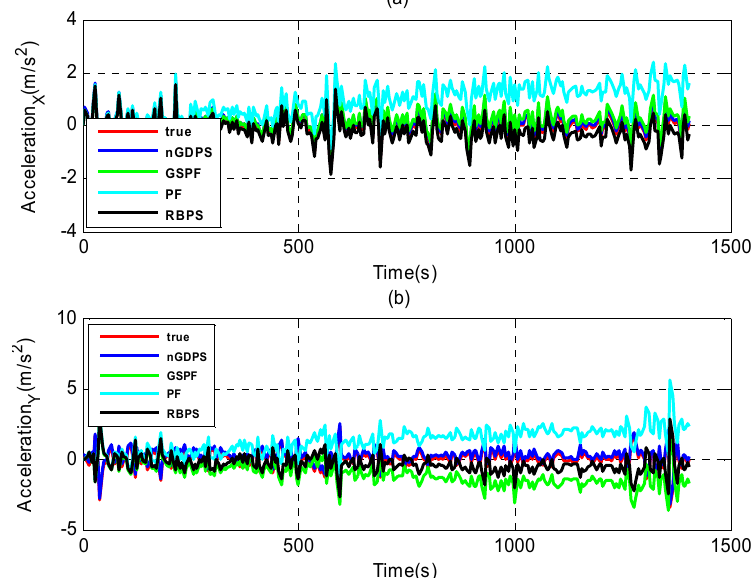
Figure 8. Estimate acceleration results of nGDPS, GSPF and RBPS versus true vehicle state in (X, Y)-coordinates. ( a ) X-coordinates; ( b ) Y-coordinates.